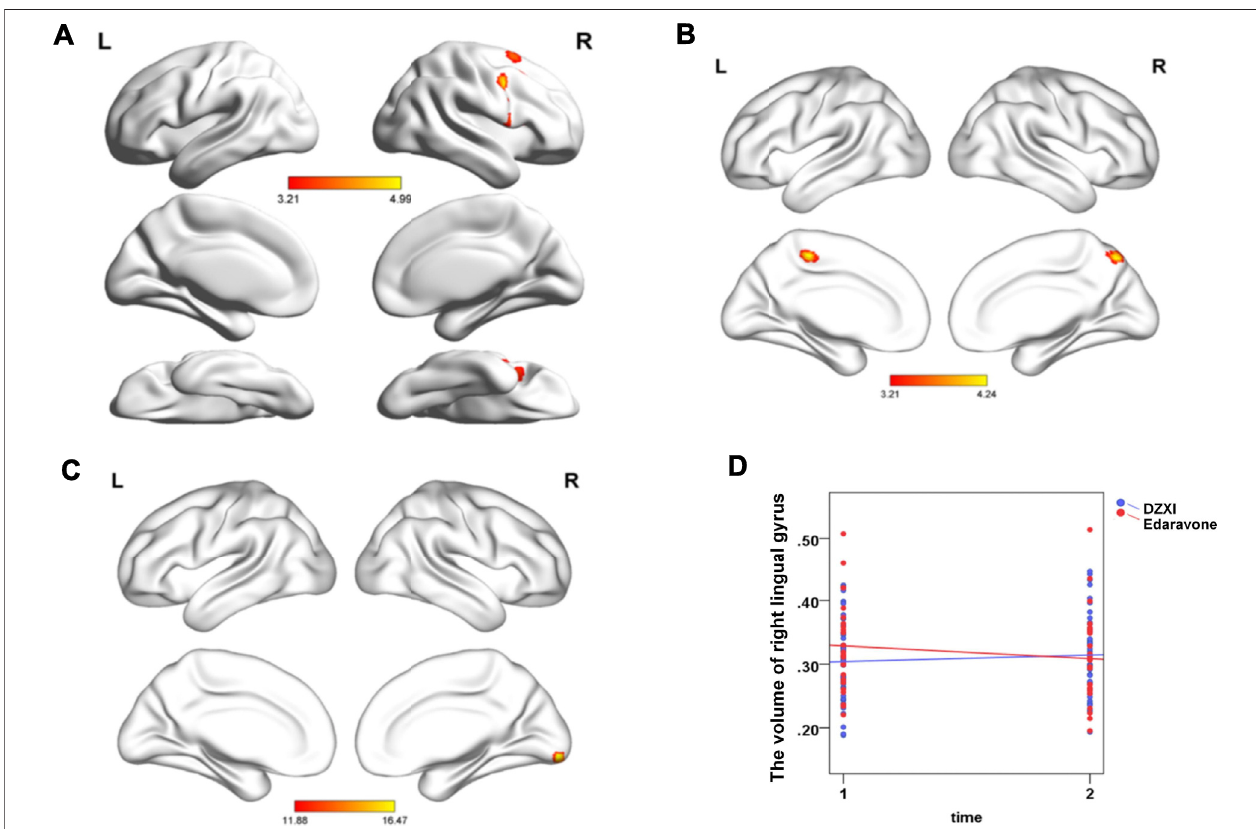
FIGURE 2 | DZXI and edaravone protected the grey matter in speci fi cregions of patients with AIS. Paired t -test was used to explore the volume changes between baselineandafter2 weeksoftreatmentbothintheDZXIandedaravonegroup.Afullfactorialanalysiswithage,genderandyearsofeducationascovariateswasusedto explore the interaction between time and groups. After fi nding the cluster with signi fi cant interaction effects between drugs x treatment time, we used the cluster as ROI andextractedthevolumevalueofeachsubjects. (A) Therighthemisphereinregionssuchastheprecentralgyrus,centralsulcus,superiorfrontalgyrus,andmiddle andinferiorfrontalgyruswereprotectedbyDZXI. (B) Theleftparacentrallobuleandrightprecuneuswereprotectedbyedaravone. (C) Inthecomparisonofthetwotime points, the volume of the right lingual gyrus exhibited signi fi cant interaction effects between DZXI and edaravone groups. (D) DZXI treatment had a better effect on inhibitingthe decrease ofthe volume ofthe right lingual gyrus, compared with edaravone group. n (cid:2) 47 in DZXI group and 25 in edaravonegroup. Time 1, baseline; time 2, the end of treatments; blue, DZXI group; red, edaravone group. Each point represents an individual volume of the right lingual gyrus, and lines represent the average volumes.